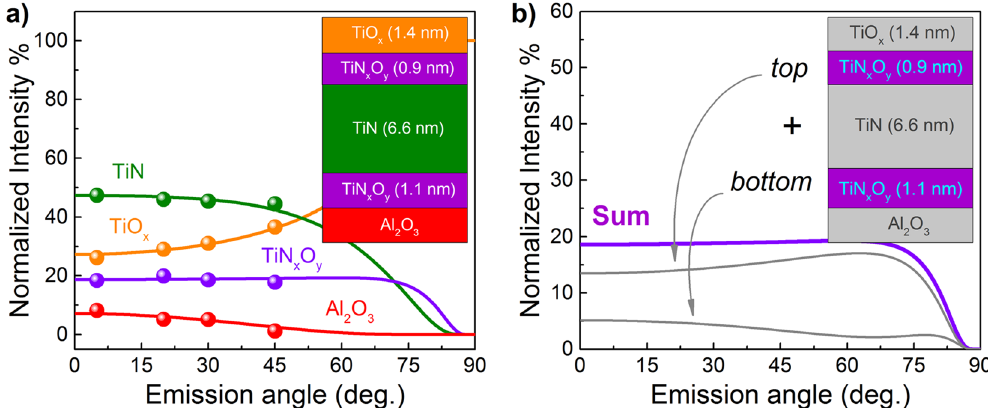
Figure 3. ( a ) Experimental (dots) and calculated (lines) values of HAXPES peak intensities for different electron emission angles using the five-layer model for TiN/Al 2 O 3 /Si sample (3010 eV excitation). For clarity, all the intensities are normalized using the constants σ , c , λ , γ and A exp( θ ). Panel (b) illustrates the simulated angular behavior of peak intensities associated with electron emission from the top and bottom TiN x O y layers and their resulting sum.